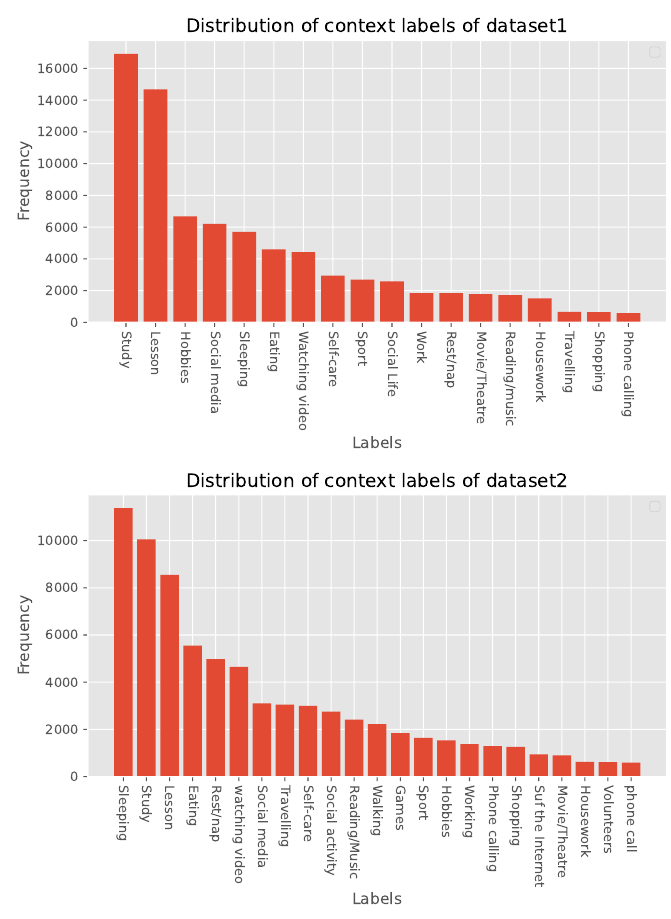
Figure 6. Frequency of activity